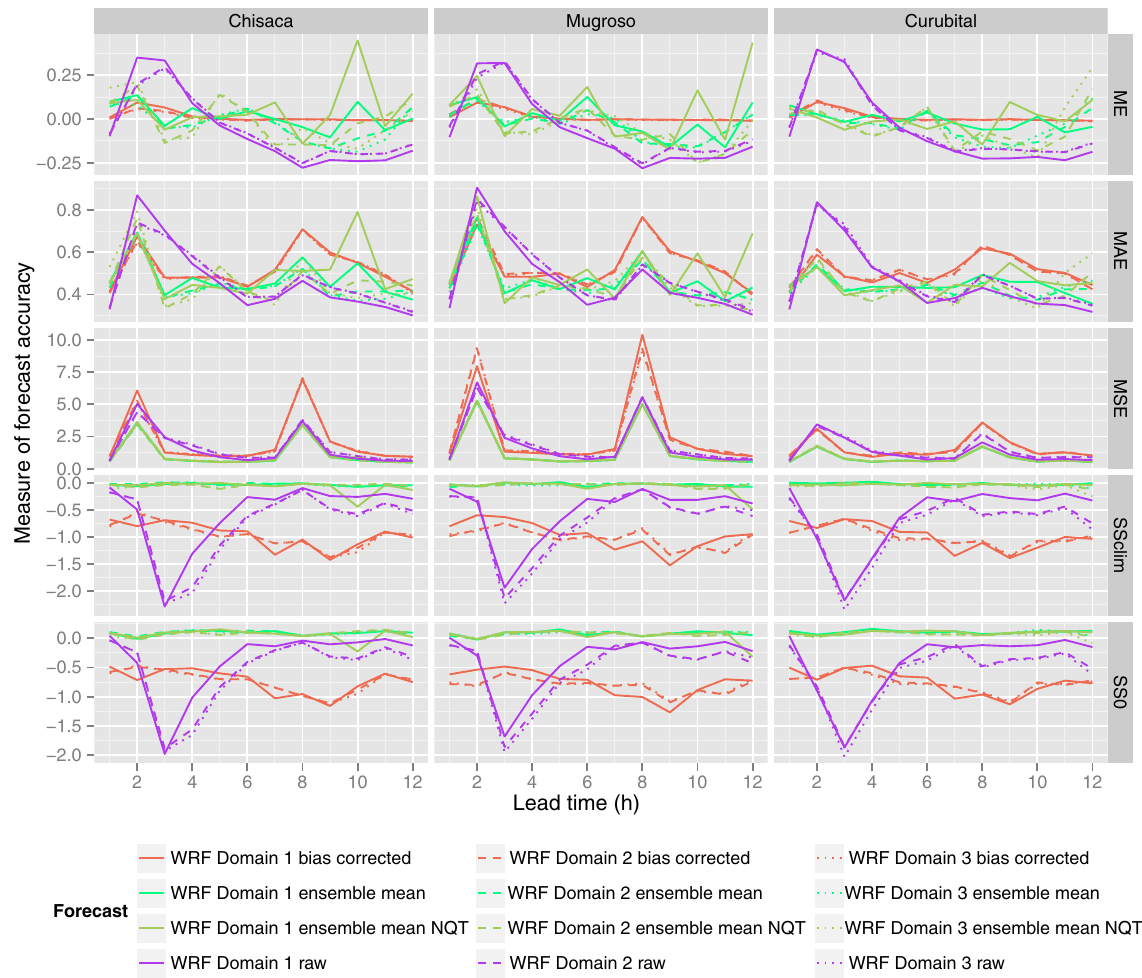
Figure 5. Accuracy measures for deterministic precipitation and ensemble mean obtained from the WRF model. Domain 1, domain 2 and domain 3 correspond respectively to the domains with resolutions 15, 5 and